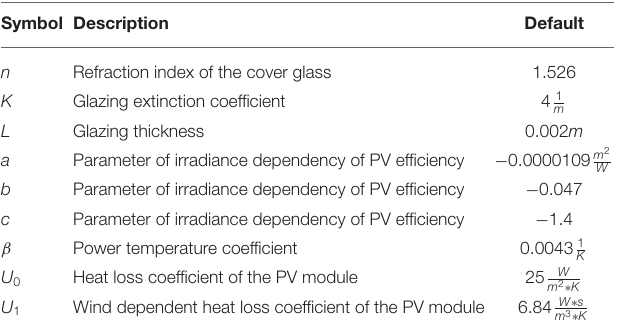
TABLE 2 | Parameters for the calculation of the varying efficiency factor and their default values.